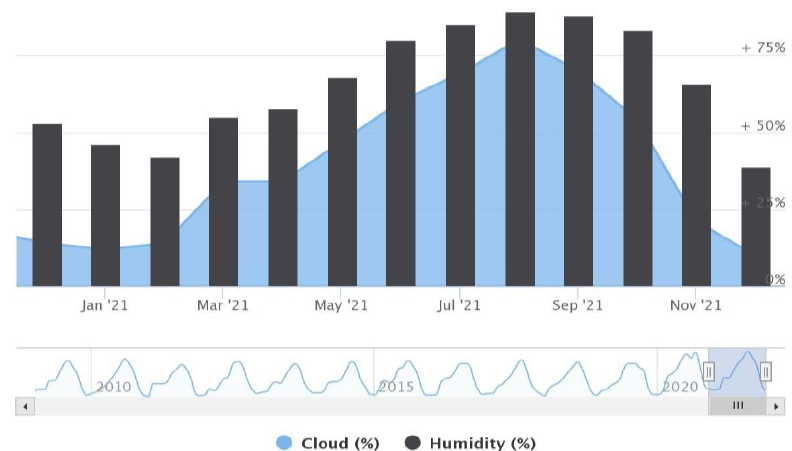
Figure 4. Mean yearly percentage of cloud and humidity of the study location.